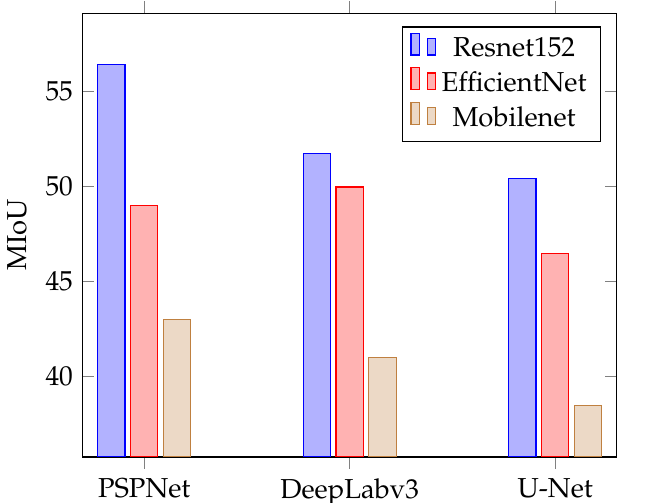
Figure 7. Accuracy (MIoU) of three neural networks and encoders used, having been trained with the baseline dataset.